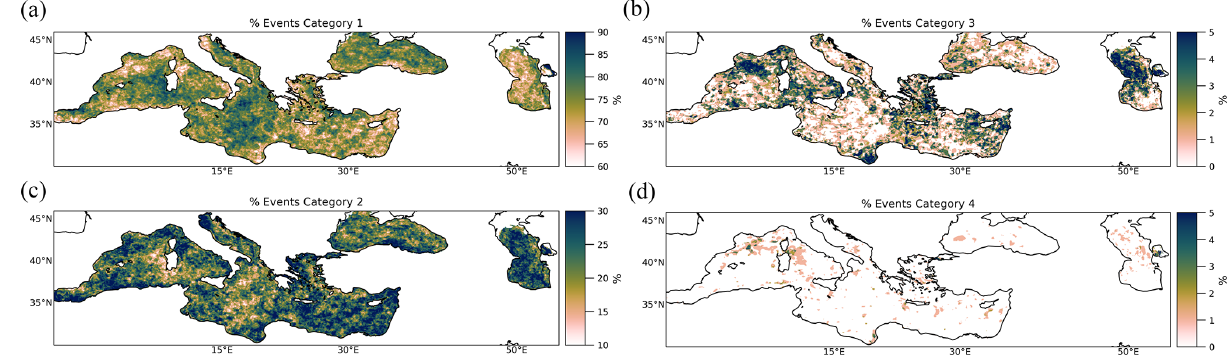
Figure 6. Percentage (%) of counted MHW events in (a) category 1, (b) category 2, (c) category 3, and (d) category 4. The color schemes used in this figure are produced using the “Scientific colour maps” package (Crameri et al., 2020).